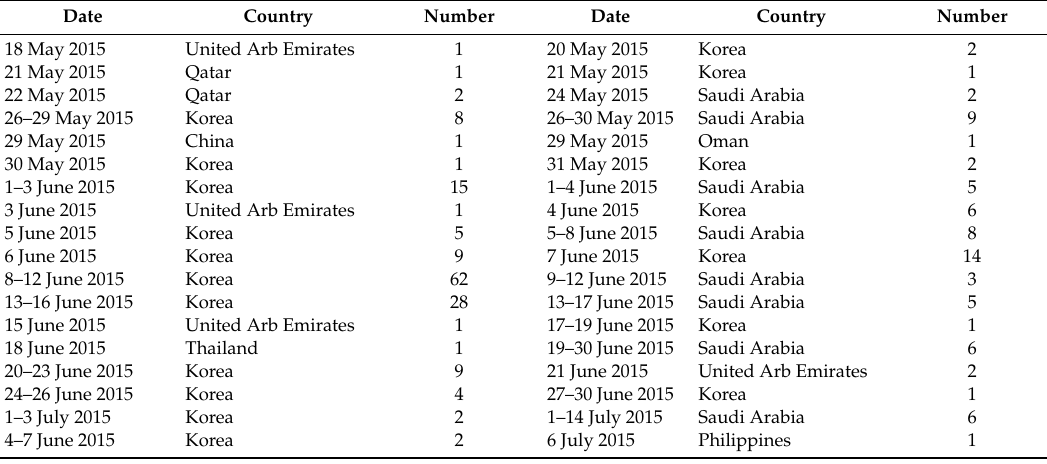
Figure 10. Events corresponding to the abnormal troughs. ( a ) Military activities in the Persian Gulf on 18 October 2014 (https: // www.onr.navy.mil / en / Media-Center / Press-Releases / 2014 / LaWS-shipboard- laser-uss-ponce); ( b ) Military activities in the Persian Gulf on 10 December 2014 (https: // www.navy. mil / view_image.asp?id = 186243); ( c ) The situation of countries involved in the MERS outbreak in 2015 (https: // www.who.int / csr / don / archive / disease / coronavirus_infections / en / ). Table 4. Number of cases in various countries during the MERS epidemic in 2015 (https: // www.who. int / csr / don / archive / disease / coronavirus_infections / en /